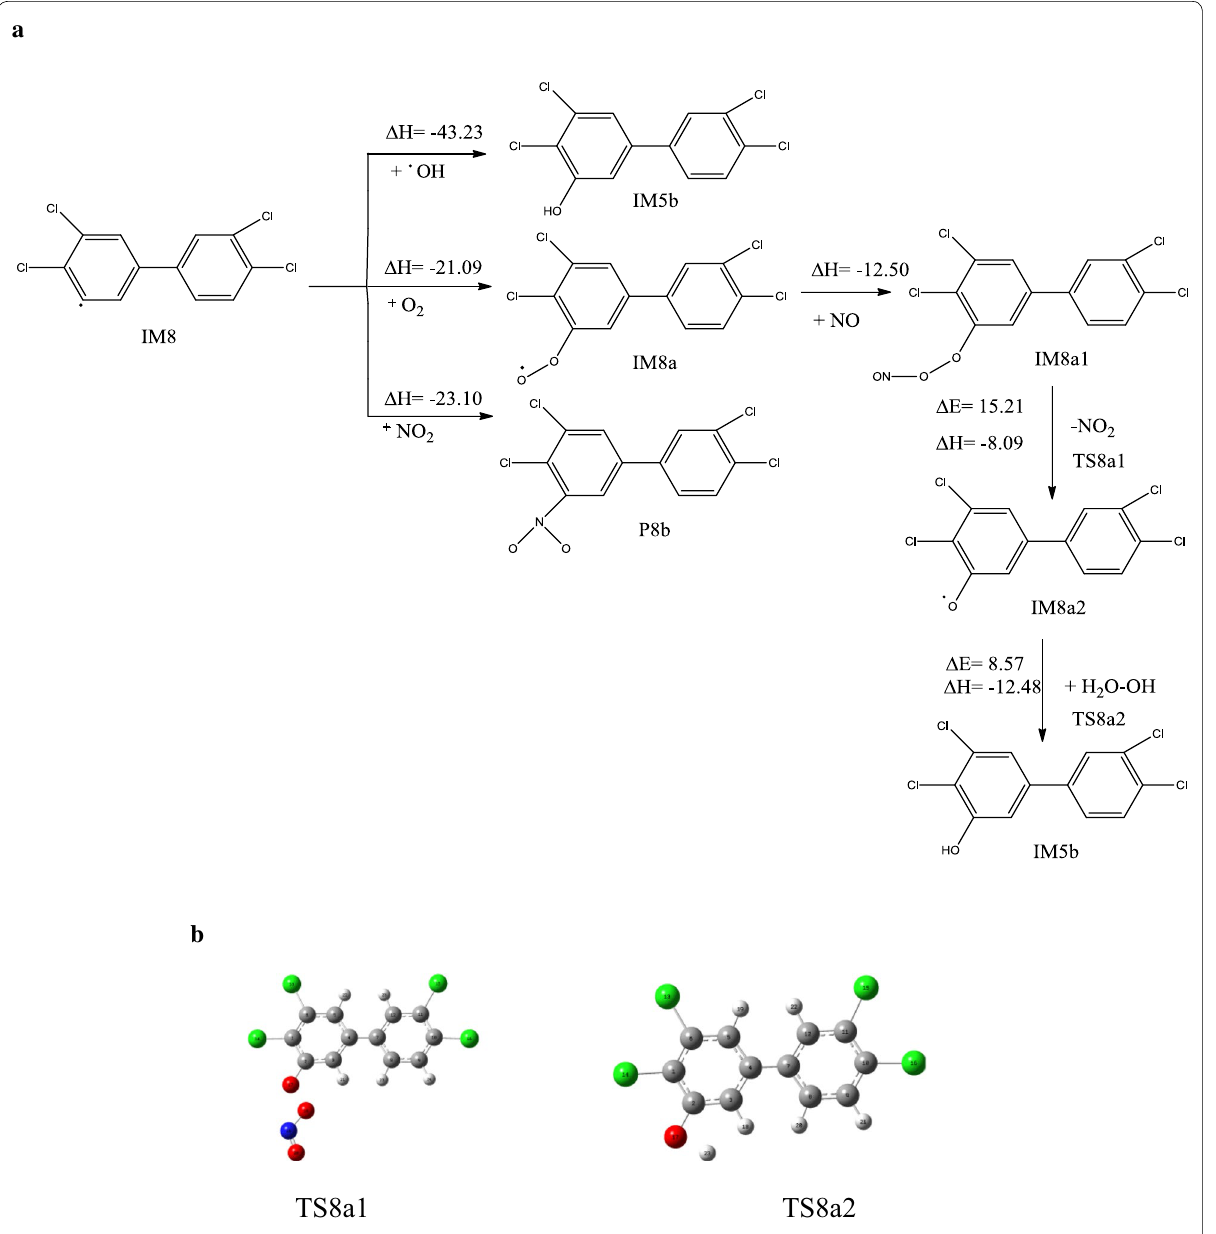
Fig. 5 Addition reaction pathway of intermediate IM8 with energy barrier, ∆H (kcal/mol): reaction